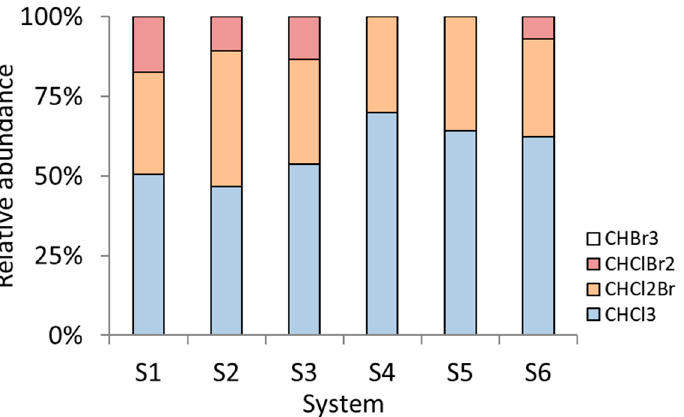
Figure 3. The relative abundance of the different THM species (CHCl 3 , CHCl 2 Br, CHClBr 2 , CHBr 3 ) in 6 h recirculated water after incubation with 5 mg/L chlorine for 1 h.